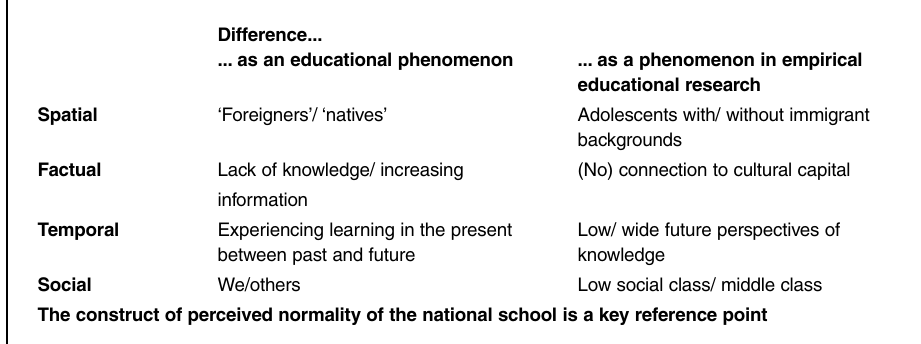
Table 2: Difference as an educational and empirical